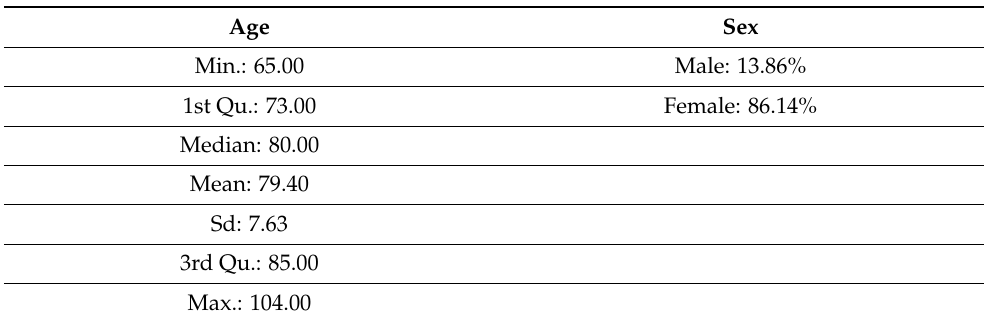
Table 1. Persons over 65 years of age living alone based on sex and age. Basic Health Areas of Gran Canaria. 2018–2020. Medians and